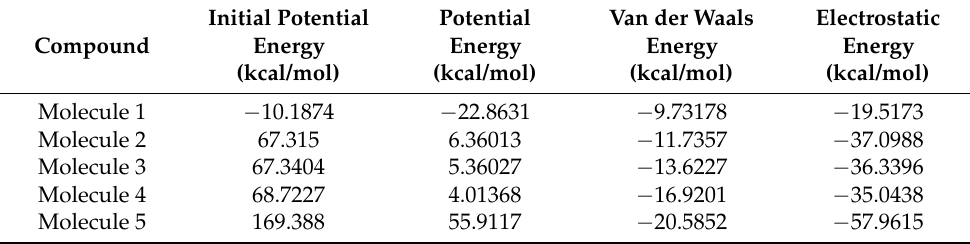
Table 2. Estimated potential energy values for the isolated molecules after energy